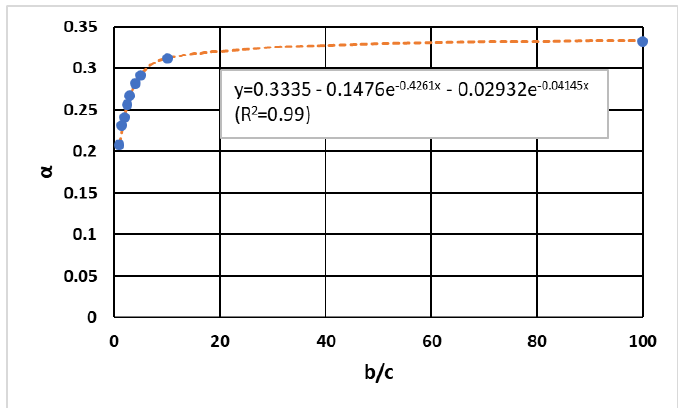
Figure 6. Torsion test of rectangular section specimens: ( a ) specimen geometry; ( b ) test set-up. T he values of α for the ratio b/c is shown in Figure 7.